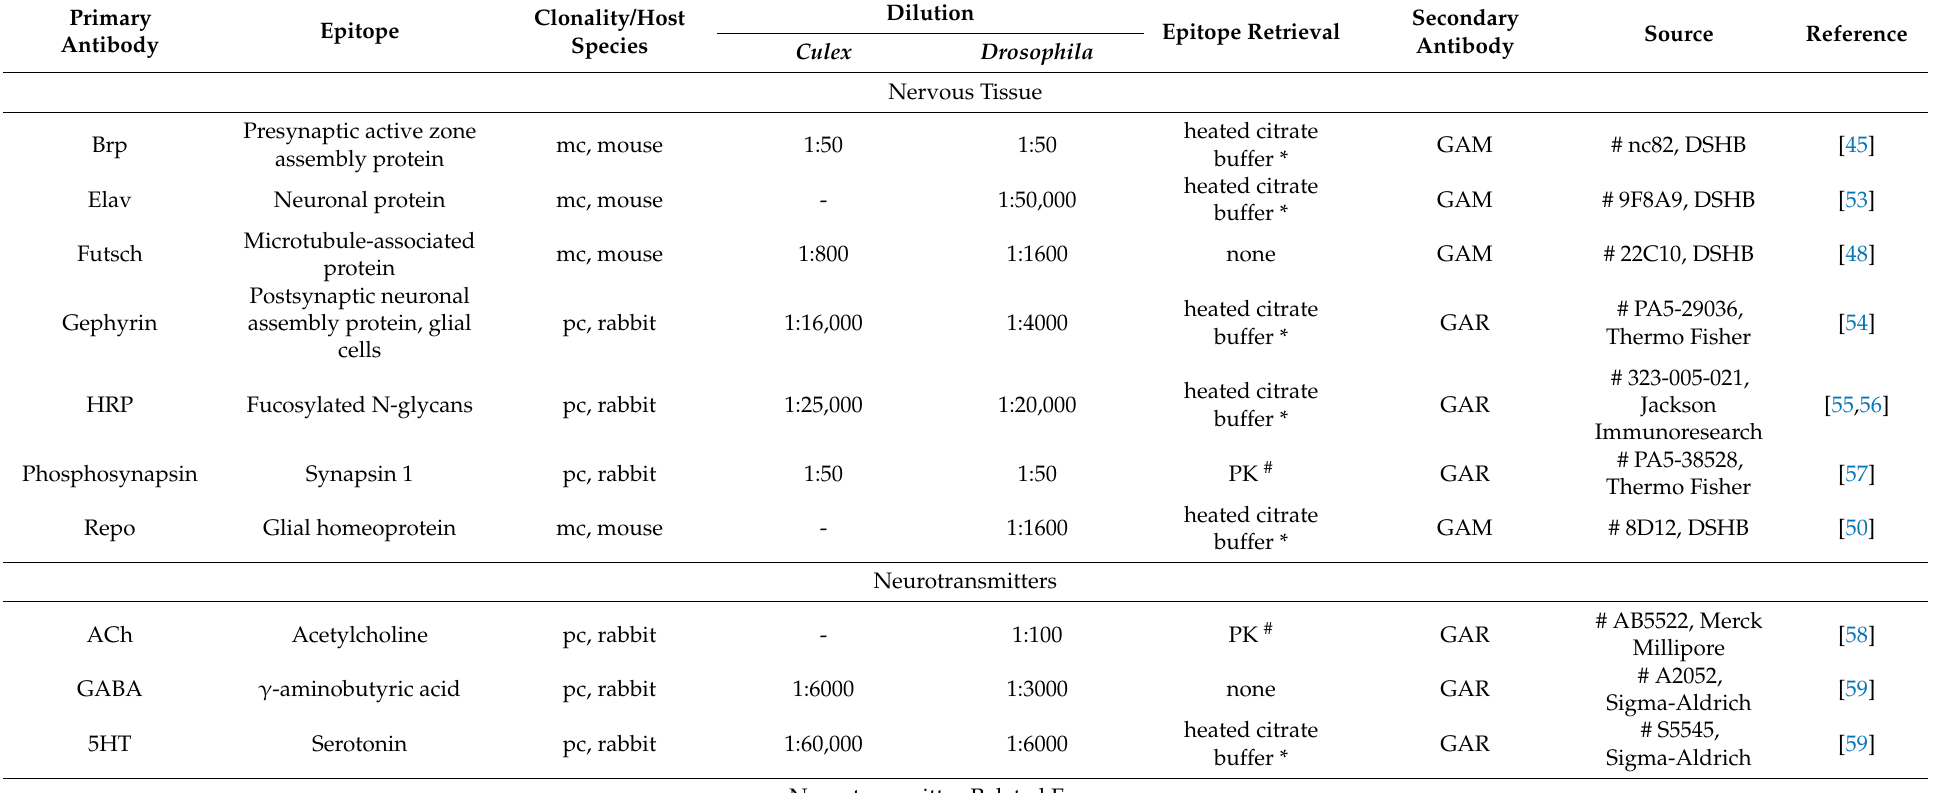
Table 1. Overview of antibodies used for characterization of the nervous system of Culex pipiens biotype molestus and Drosophila melanogaster including epitope, clonality, host species, dilution, epitope retrieval and secondary